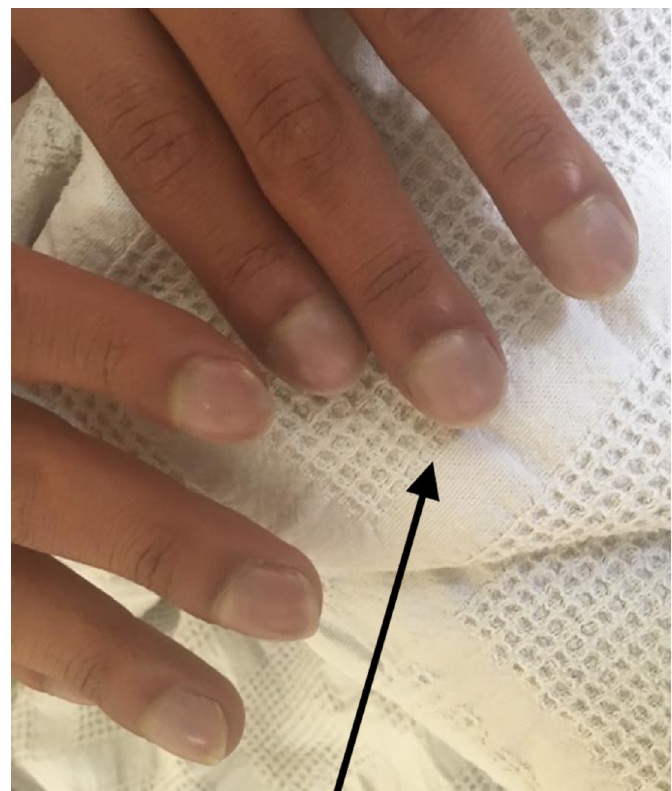
Image 1. Fingers of patient (arrow) demonstrating cyanosis and